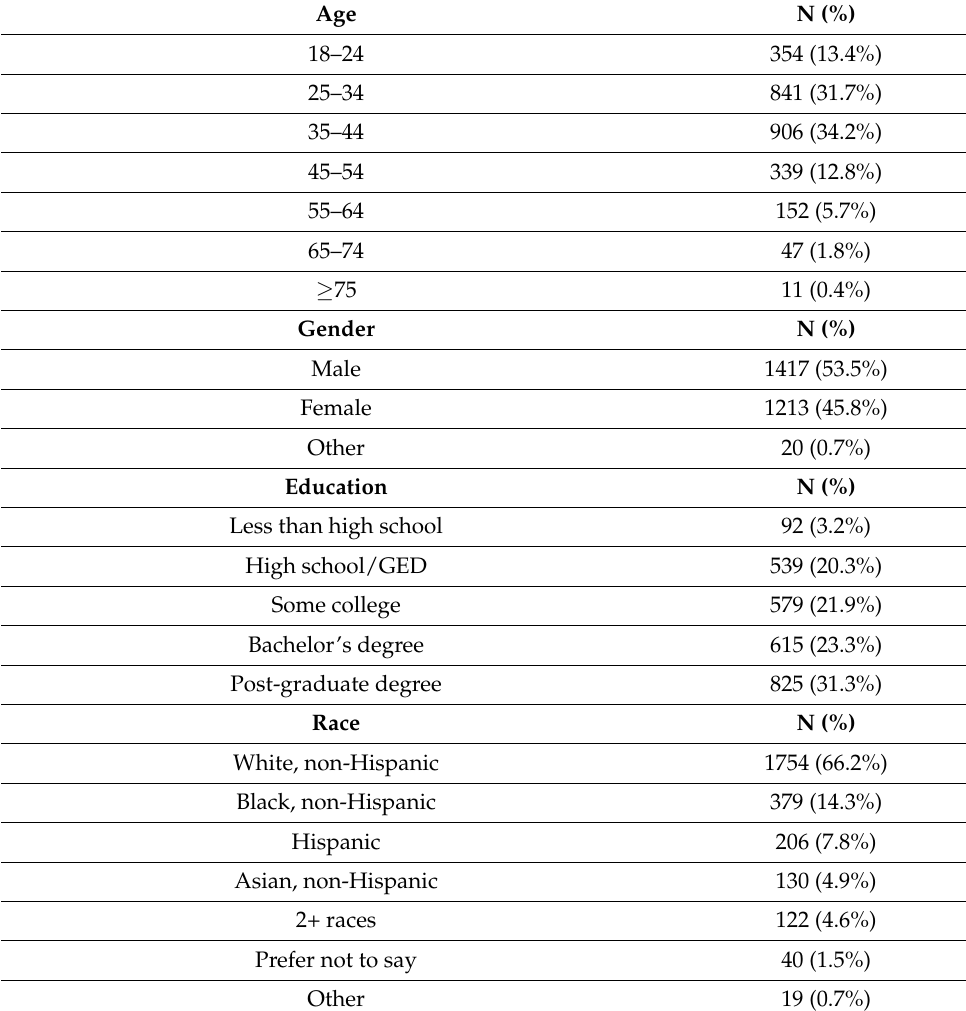
Table 1. Socio-demographic characteristics of the study